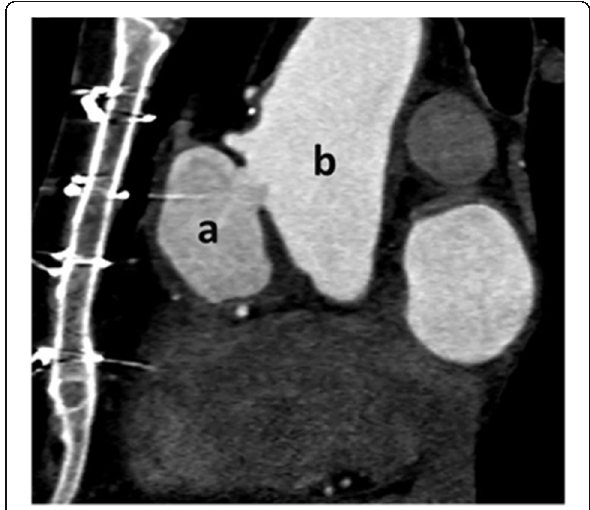
Fig. 3 Flouroscopy during aortic root injection showed a huge pseudoaneurysm, probably at previous surgical clamp site. A Pseudoaneurysm, ( B ) ascending aorta, ( C ) sinus of Valsalva, ( D ) suture of